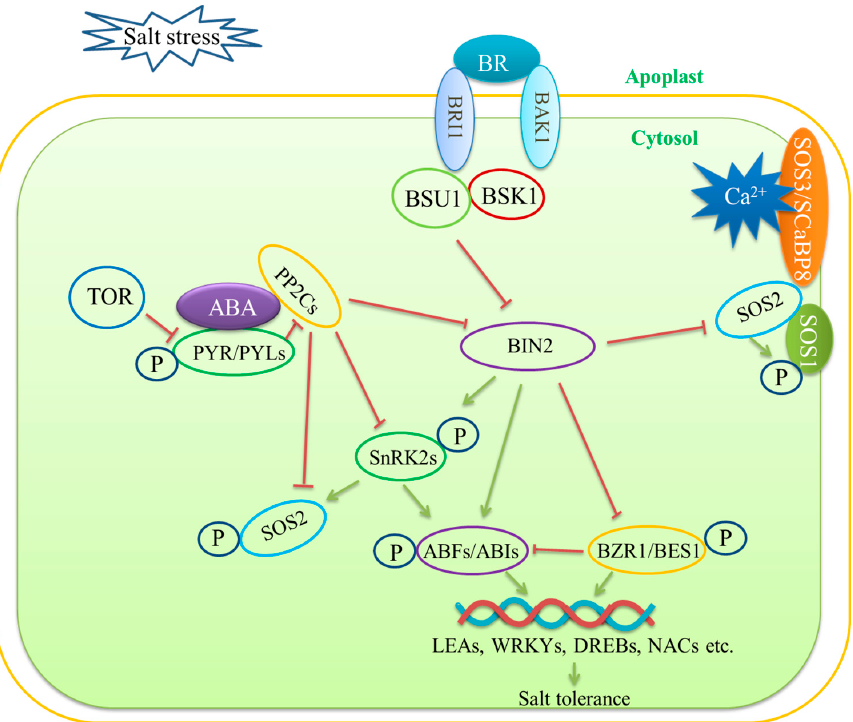
Figure 3. ABA and BR signaling during salt stress. Salt stress promotes abscisic acid (ABA) accumulation. The sucrose nonfermenting-1-related protein kinase2s (SnRK2s) and the clade A type 2C protein phosphatases (PP2Cs) play key roles in mediating the crosstalk between ABA and salt stress signaling. The ABA receptors, PYRABACTIN RESISTANCE/PYR-LIKE (PYR/PYLs) sense ABA and repress PP2Cs, thereby activating the downstream kinase SnRK2. SnRK2s phosphorylate the transcription factors ABSCISIC ACID RESPONSIVE ELEMENT-BINDING FACTORs (ABFs) and ABIs to regulate the expression of stress-responsive genes. The target of rapamycin (TOR) phosphorylates PYL and represses ABA signaling and stress responses. ABI2, a member of the PP2Cs, binds to SOS2 to inhibit its kinase activity, thereby negatively regulating salt tolerance. Additionally, under salt stress, SnRKs phosphorylate SOS2 to activate osmoregulation. Salt stress also upregulates BR biosynthesis. The membrane receptor brassinosteroid insensitive 1 (BRI1) senses BR molecules and acts with its coreceptor BRI1-associated receptor kinase 1 (BAK1) to initiate the downstream phosphorylation cascade. BRI1 and BAK1 transduce the BR signal to BR signaling kinase 1 (BSK1) and activate BRI1 suppressor 1 (BSU1). BSU1 inhibits BIN2 and promotes the transcription factors BZR1/BES1 to induce the expression of BR-responsive genes, which enhances salt tolerance. Under salt stress, BIN2 phosphorylates and inhibits SOS2. This phosphoregulation by BIN2 prevents SOS2 overactivation. Arrows and bars indicate positive and negative regulation, respectively. Solid lines and dashed lines indicate direct regulation and indirect regulation, respectively. Salt-stress-induced osmotic stress also activates ABA signaling transduction path- ways. The sucrose-nonfermenting-1-related protein kinase 2s (SnRK2s) are the central components in ABA signaling pathways and play critical roles in osmoregulation [72]. The kinase activities of SnRK2.2/3/6 are inhibited by protein phosphatase 2Cs (PP2Cs) in the absence of ABA. Upon osmotic stress, the ABA receptor proteins, including pyrabac- tin resistance 1 (PYR1), PYR1-like (PYL), and regulatory component of ABA receptors (RCAR), perceive and bind to the accumulated ABA, which subsequently suppresses the phosphatase activity of PP2Cs [66,72]. As a result, in the absence of inhibition by PP2Cs, SnRK2s are quickly activated. After stress removal, PYL is phosphorylated by the target of rapamycin (TOR) kinase and then disassociates from ABA or PP2C, leading to inacti- vation of the stress response to promote growth recovery [73]. Recent studies suggest that the upstream kinases, namely, the B2, B3, and B4 Raf-like kinases, are quickly acti-